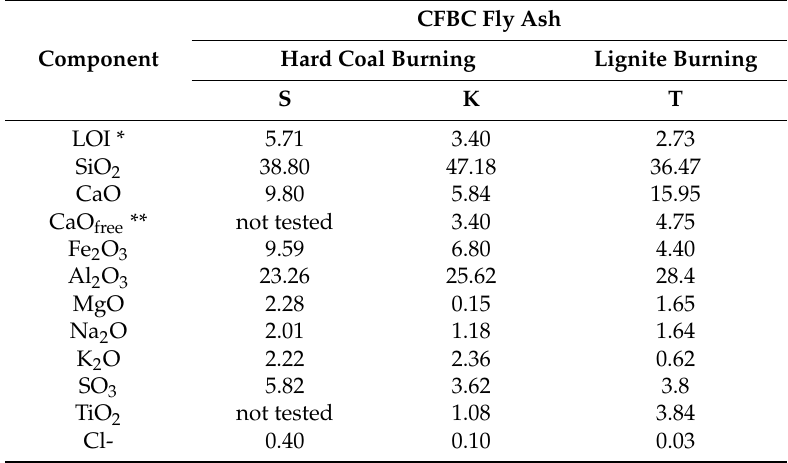
Table 1. Chemical composition of circulating fluidized bed combustion (CFBC) fly ash determined by X-Ray Fluorescence Spectroscopy XRF method (wt